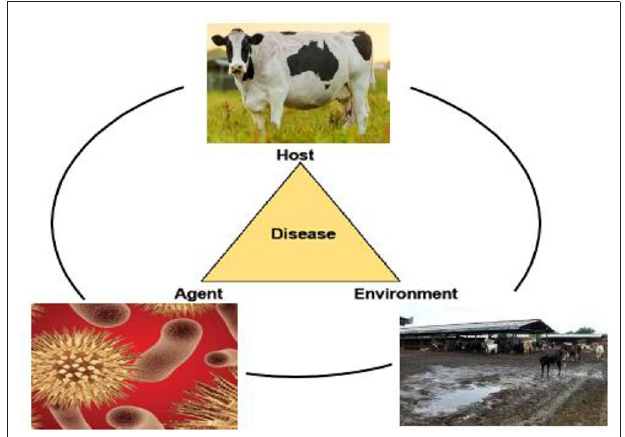
FIGURE 1 | Factors contributing to bovine